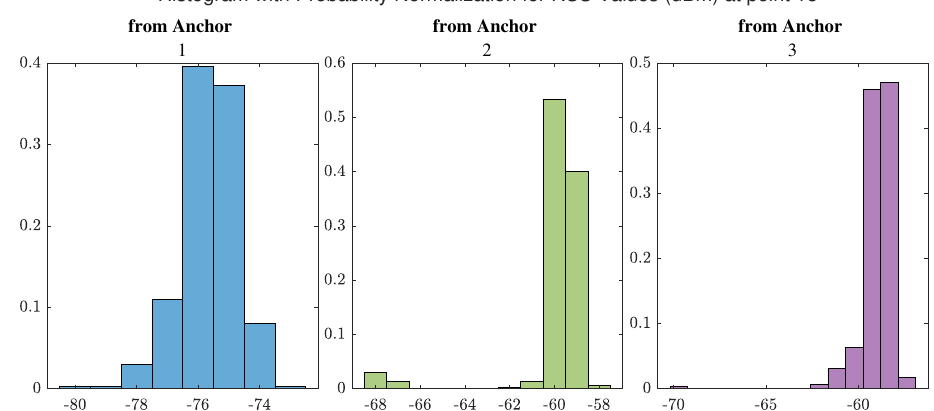
Figure 14. Distribution of RSS values received from WiFi anchors at point 18.